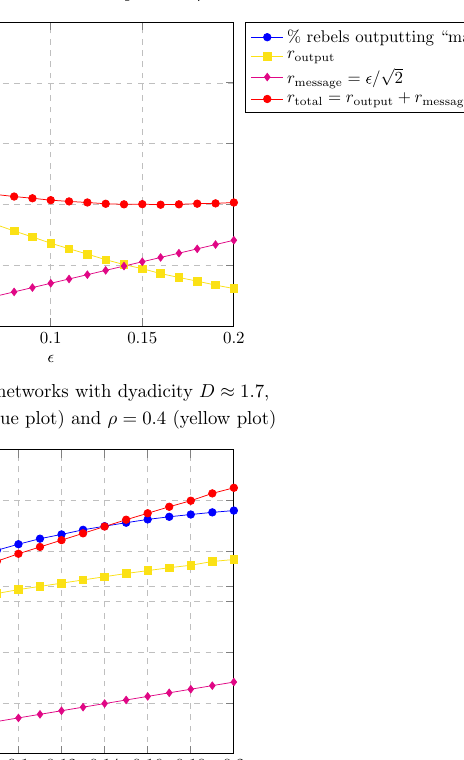
(a) simulations on Facebook sample with ρ = 0 . 8 (b) simulations on Facebook sample with ρ = 0 . 2